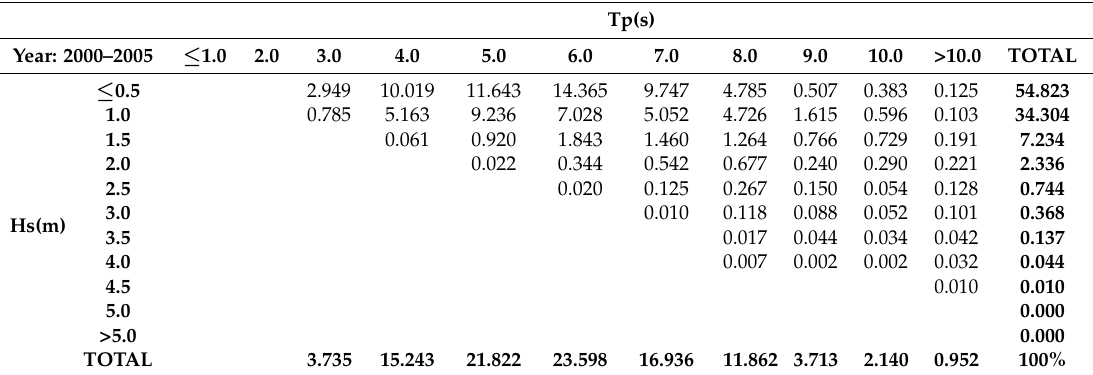
Table 7. Hs/Tp table at the Valencia Buoy between years 2000–2005. Source: www.puertos.es.